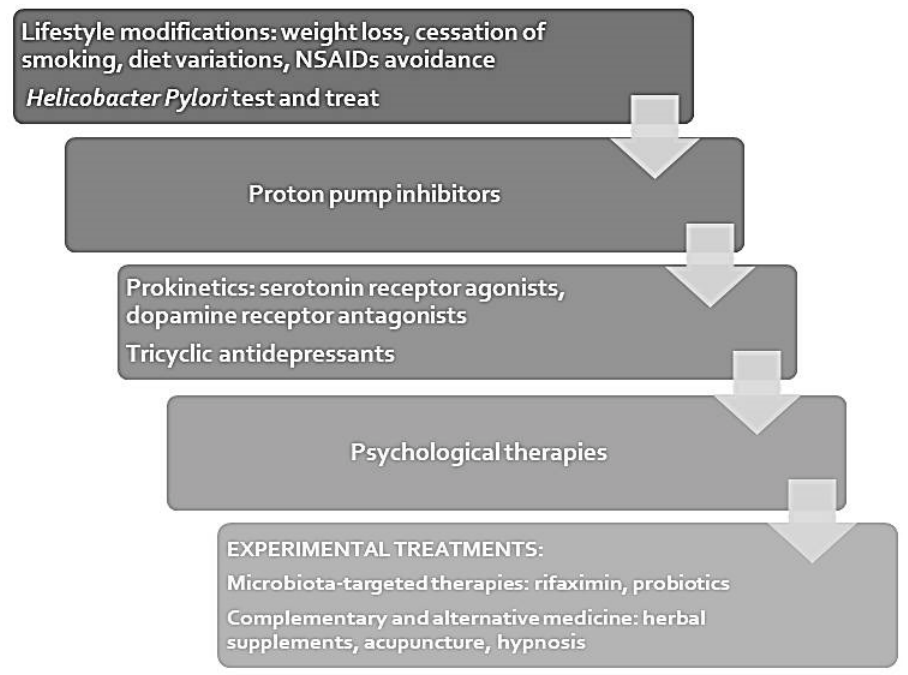
Figure 1. Treatment algorithm for functional dyspepsia.